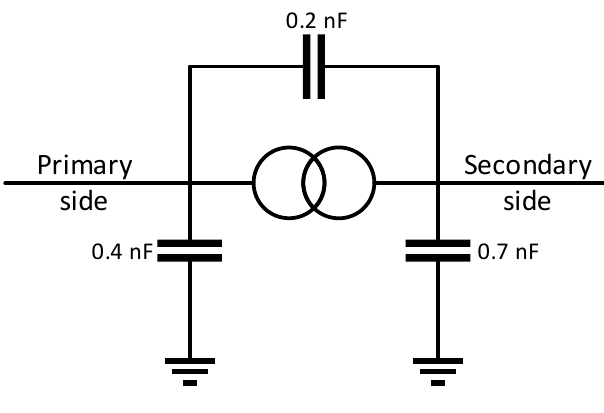
Figure 6. Transformer model.